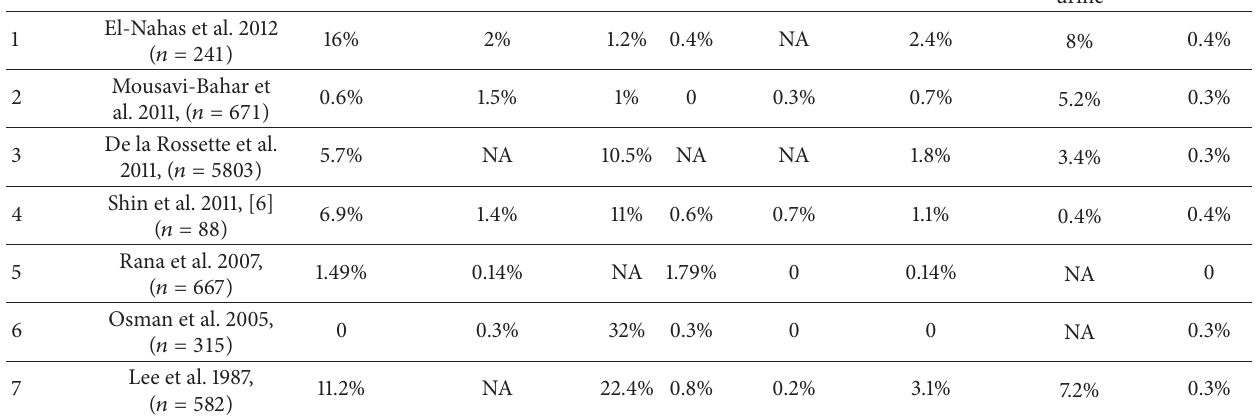
Table 2: Studies on complications of